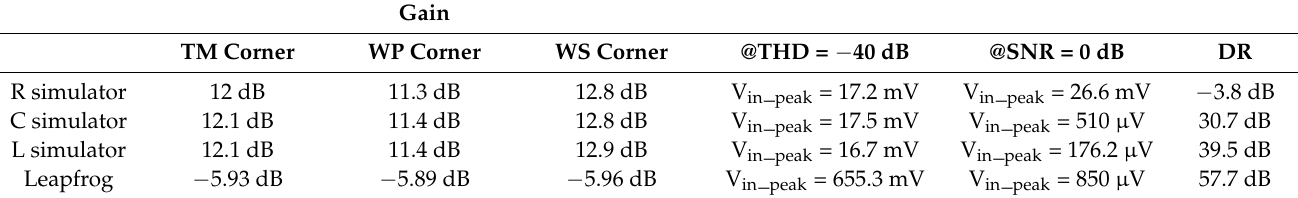
Table 8. Corner analysis for the midband gain.